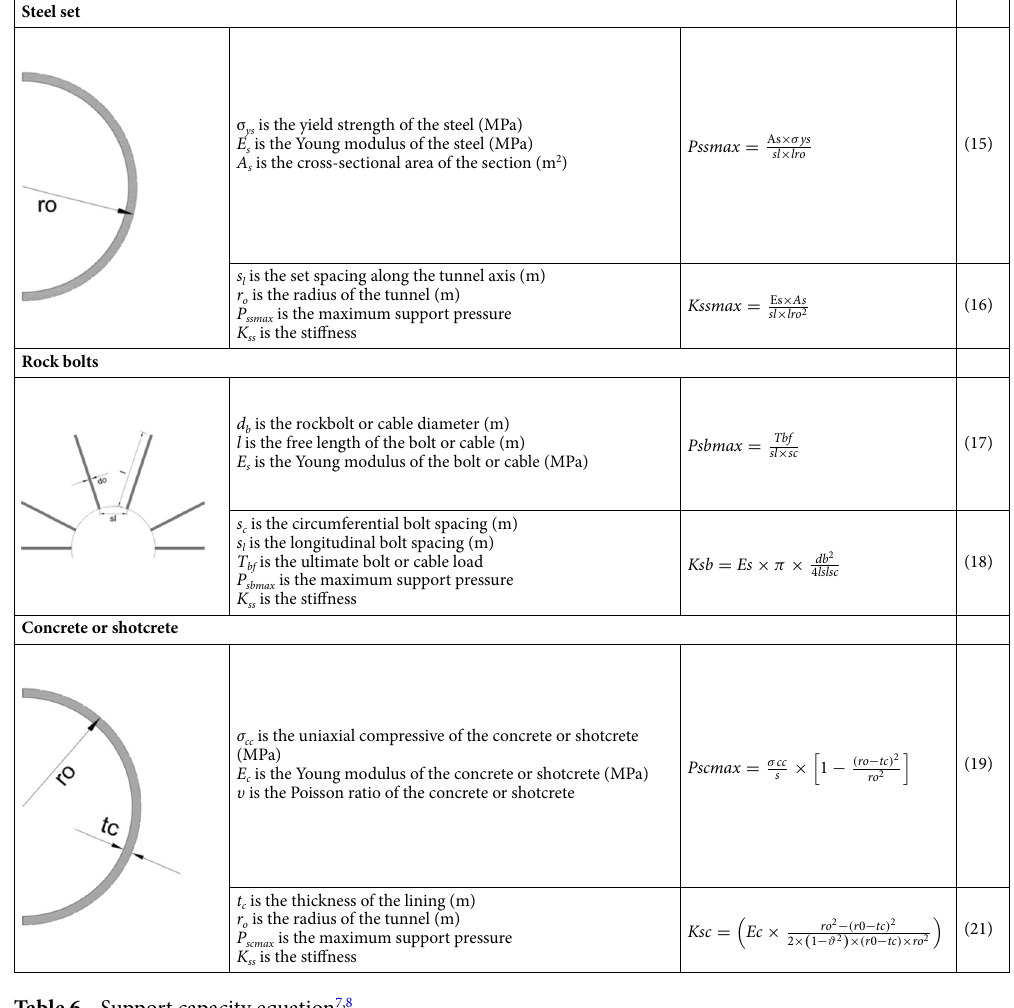
Table 6. Support capacity equation 7,8 .